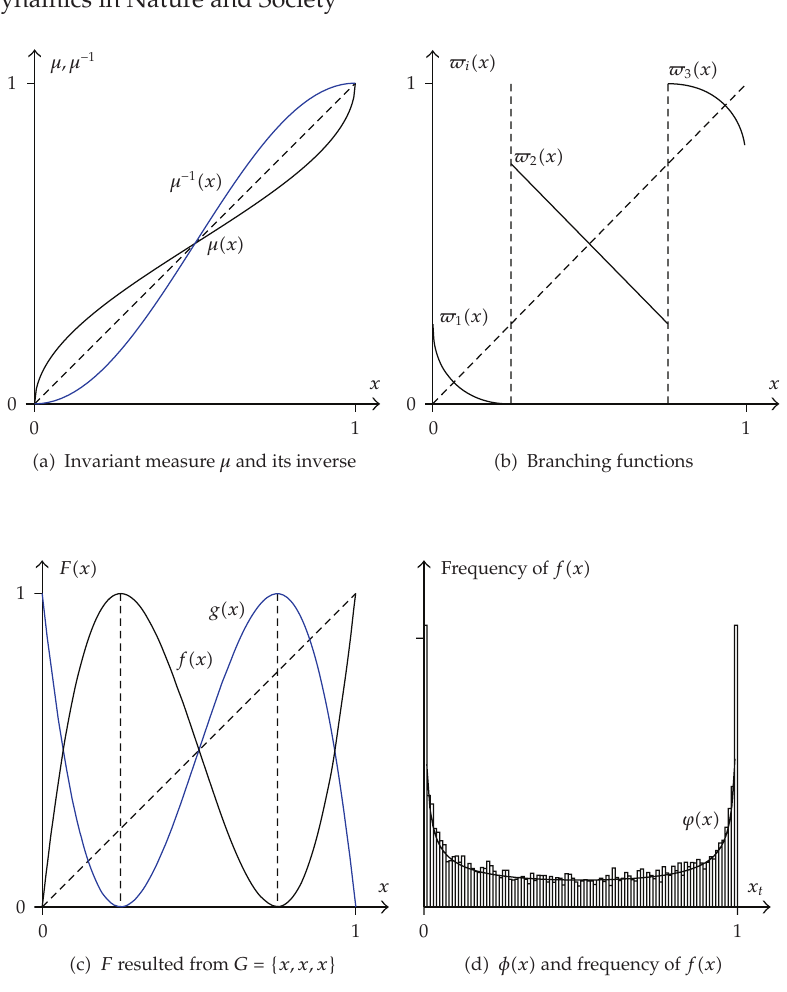
Figure 3: Illustration of Example